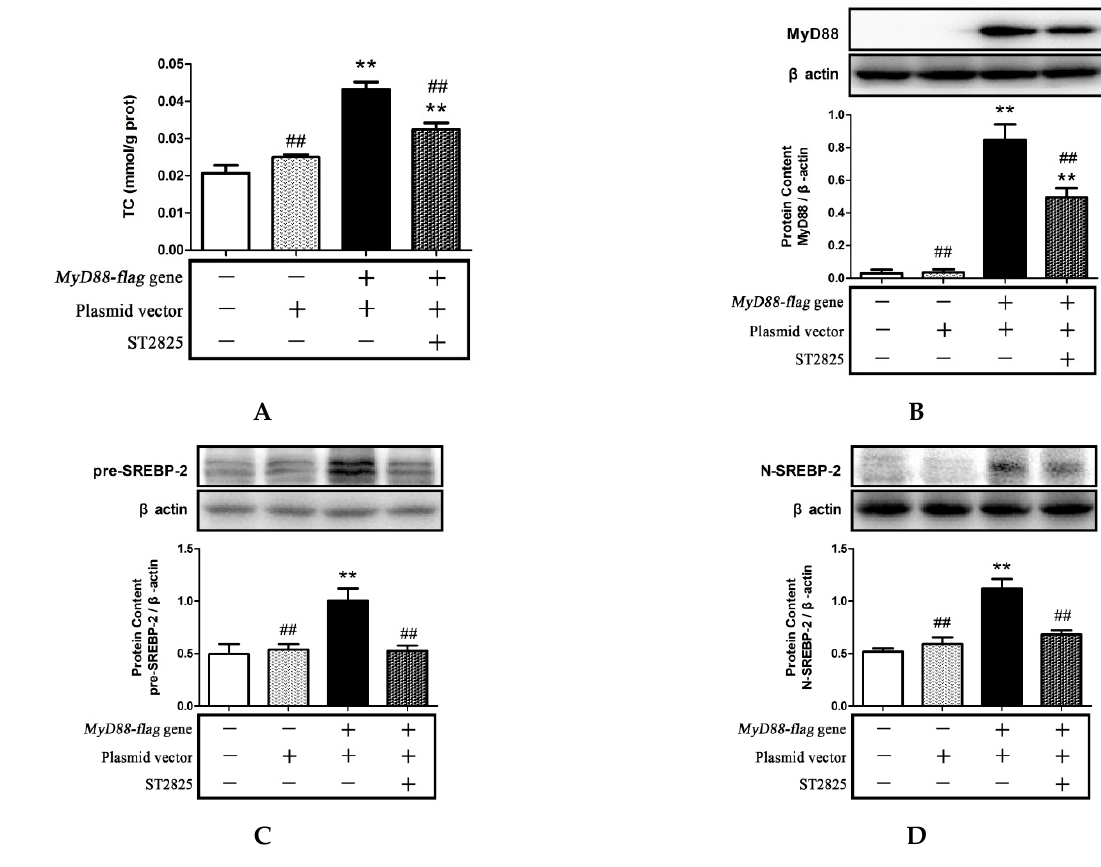
Figure 7. MyD88 inhibitor ST2825 inhibited cholesterol content and SREBP-2 expression in MyD88-transfected HEK293T cells. HEK293T cells were transfected with MyD88-flag plasmid for 24 h and then treated with 20 μ mol/L ST2825 for 6h. Intracellular TC was determined with a commercial kit ( A ). The protein expressions of MyD88 ( B ), SREBP-2 precursor (pre-SREBP-2) ( C ), and SREBP-2 mature forms (N-SREBP-2) ( D ) were measured by Western blotting. The results are presented as means ± SD of three independent experiments; **: p < 0.01 vs. control; ##: p < 0.01 vs. MyD88-flag-plasmid-transfected group.